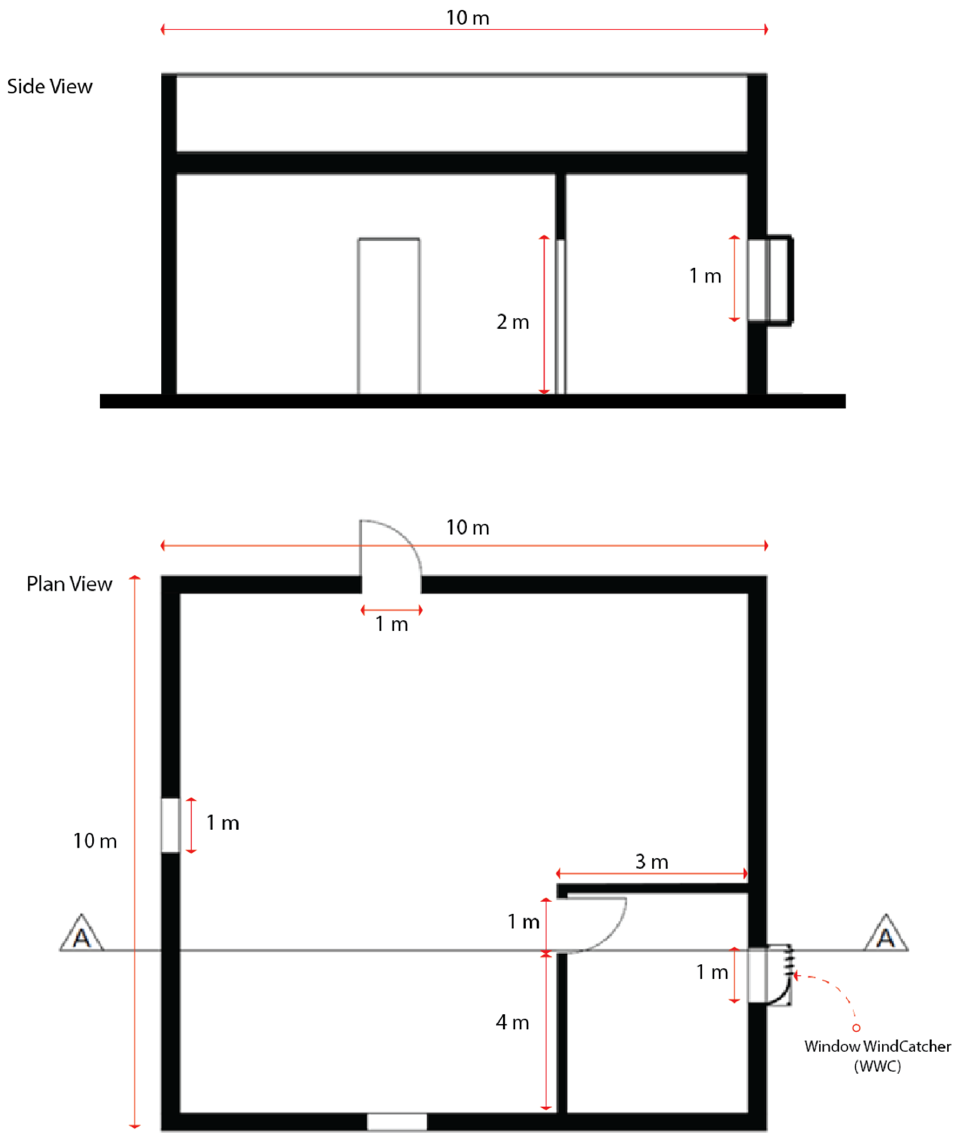
Figure 1. The dimensions of the building.